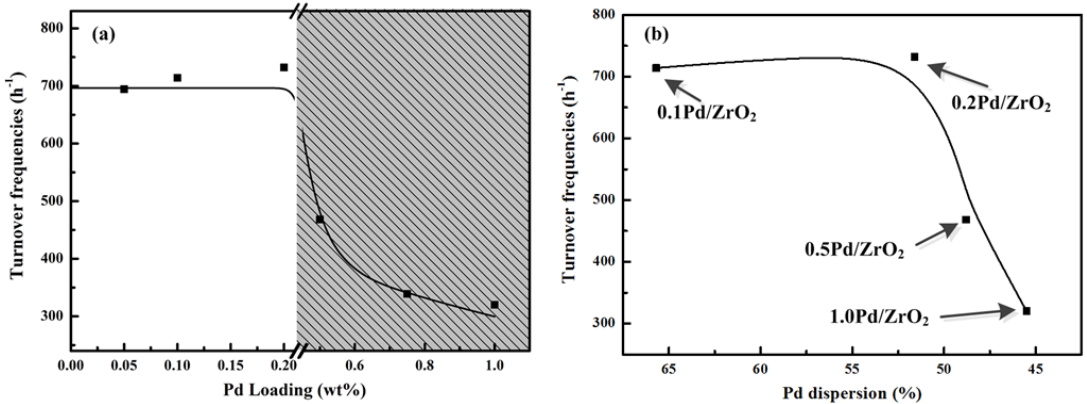
Figure 4. Turnover frequencies as function of Pd Loadings ( a ) and dispersion ( b ) for Pd/ZrO 2